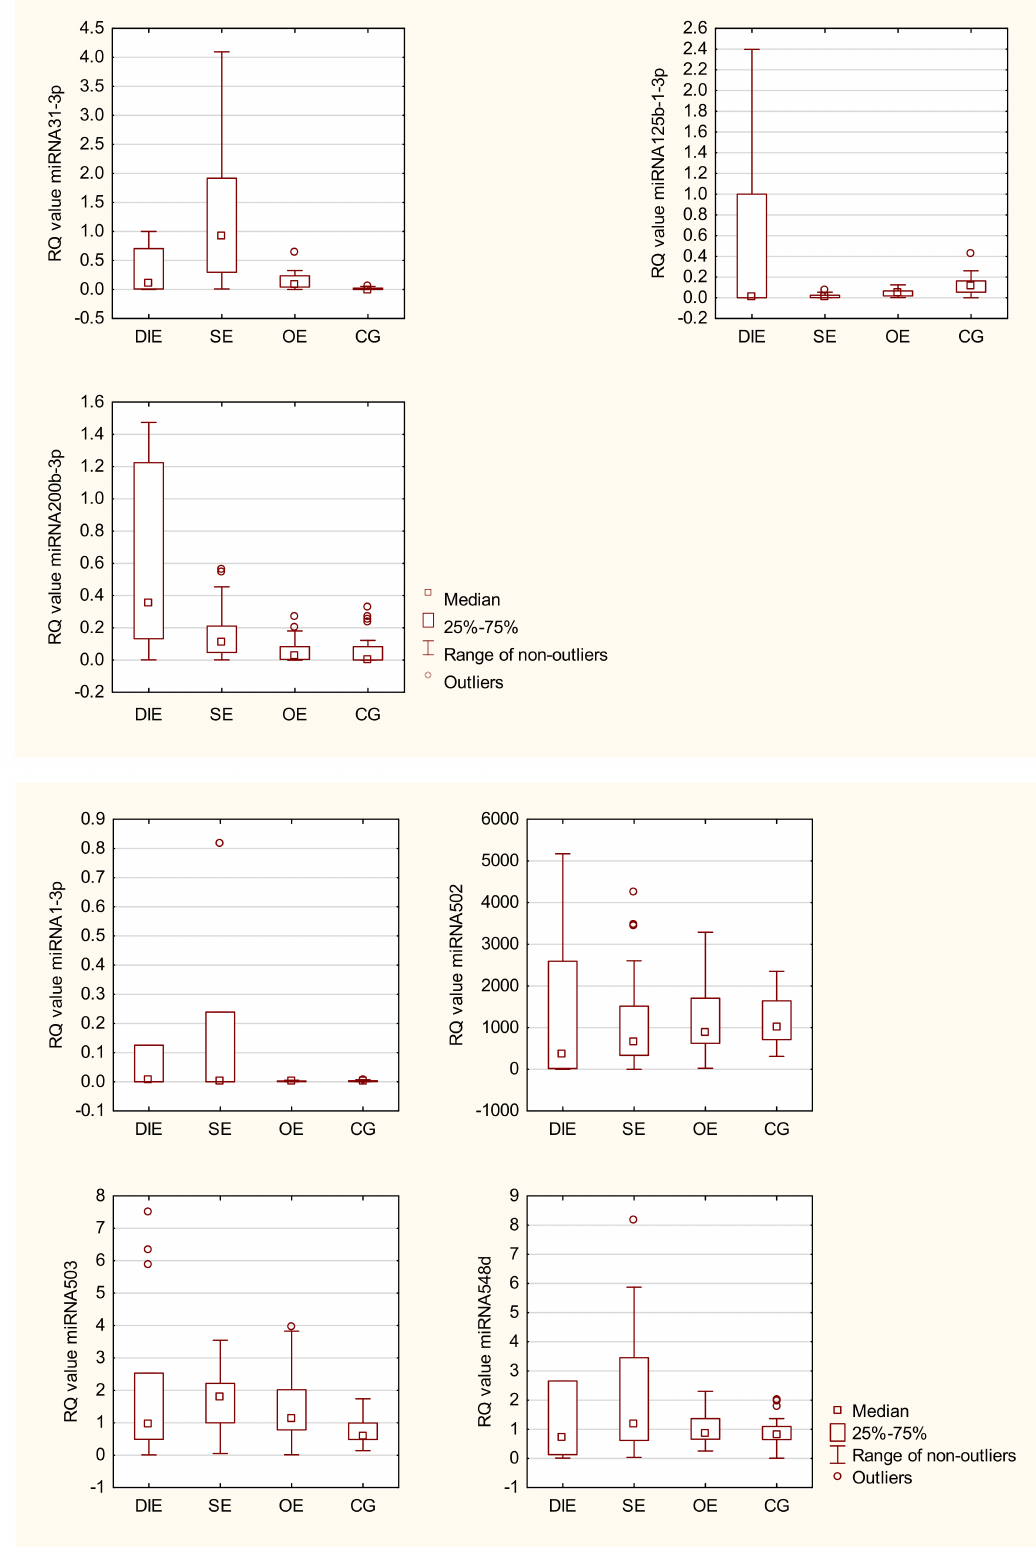
Figure 1. Box and Whisker plots of the Relative Quantification values for miR-31-3p, miR125b-1-3p, miR200b-3p, miR1-3p, miR-502, and miR548d. Extreme outliers are not shown in this figure. All data is presented in Supplementary File